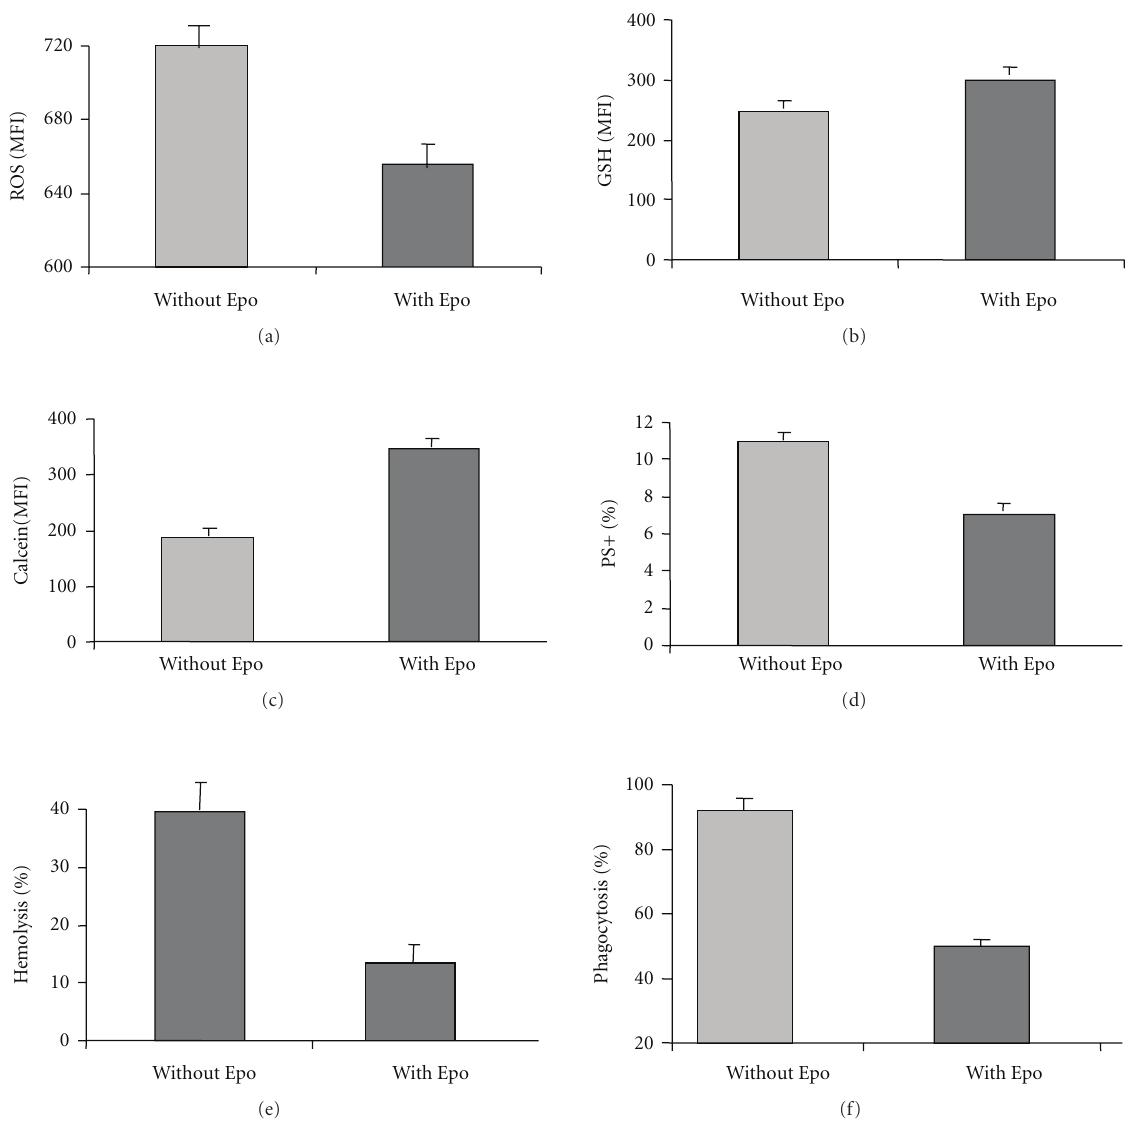
Figure 6: The long-term e ff ects of Epo on RBC oxidative markers, ageing, and susceptibility to hemolysis, and phagocytosis. Thalassemic RBC were diluted to 4 × 10 6 /ml with their plasma and incubated with or without Epo (2U/ml) for 3 days. The cells were then harvested and assayed for ROS (a), GSH (b), calcein (c), external phosphatidylserine (PS) (d), hemolysis (e) and phagocytosis (f) as detailed in Section 2. The results in (a), (b) and (c) are presented the mean fluorescence index (MFI), in (d) as the percentage of PS positive RBC, and in (e) and (f) as the percentage of hemolysed and phagocytosed RBC, respectively, compared to the RBC input. The data are the average ± SD of 4 experiments performed with blood samples derived from di ff erent